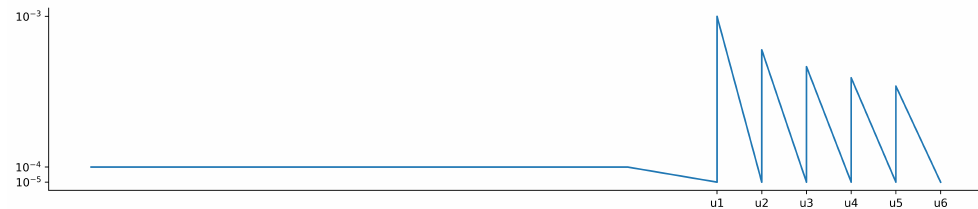
Figure 4. Learning rate schedule for SWA updates. Each SWA update is performed when the learning rate is at the minimum ( u 1, u 2, . . . , u 6).